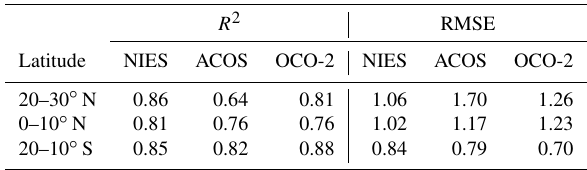
Table 2. Coefficient of determination ( R 2 ) and root-mean-square error (RMSE) between obs. XCO 2 and satellite XCO 2 retrievals from GOSAT (NIES, ACOS) and OCO-2 at different latitude ranges between 2014 and